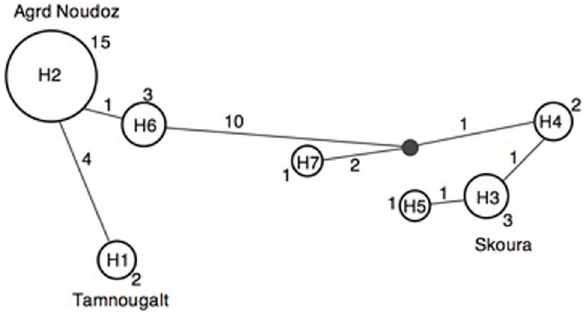
Figure 3. Medium Joining (MJ) network of all seven C.emmae haplotypes based in COI partial sequences (622 bp) showing the frequency of each haplotype. The size of the circles corresponds to the haplotype frequency and it is indicated by the numbers by the circles. The small dark colored circle indicates an undetected intermediate haplotype state. Numbers by lines indicate numbers of mutations between haplotypes.